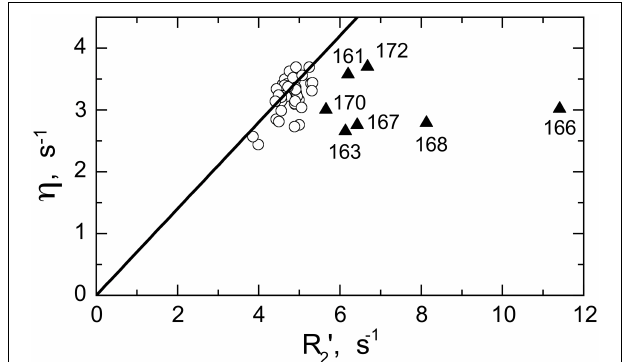
FIGURE 6 | Model-independent verification of the conformational exchange broadening using η vs. R ′ 2 plot. Shown are data for SH3 circ - G 1 measured at 600 MHz. The data points with significant shift to the right (triangles) from the linear dependence η vs. R ′ 2 (Fushman and Cowburn, 1998) correspond to those residues (indicated) involved in conformational exchange, in excellent agreement with the results of our model-free analysis of 15 N relaxation data (cf. Figure 5E ). The solid line corresponds to 15 N CSA of − 160ppm and a 20 ◦ angle between the 15 N CSA and 1 H- 15 N dipolar tensors. A rough estimate of R ex values directly from the horizontal shift in the data is in good agreement with those from model-free analysis ( Figure 5E ): 0.8 s − 1 (Ile161), 1.6 s − 1 (Asp163), 4.9 s − 1 (Glu166), 1.7 s − 1 (Glu167), 2.9 s − 1 (Gln168), 0.9 s − 1 (Trp170), 1.0 s − 1 (Ala172), all numbers were divided by (1.2) 2 to scale to 500 MHz.